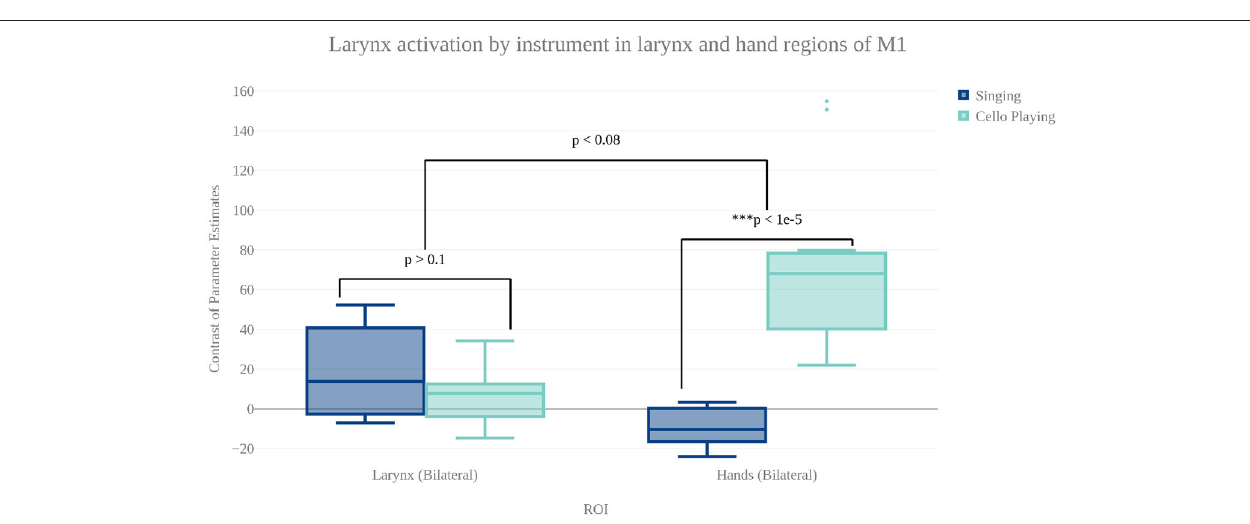
FIGURE 8 | Contrast of parameter estimates (units arbitrary) in larynx and hand area of motor cortex for singing (blue) and cello playing (turquoise). The anova showed no significant effect of instrument or brain area, but did show a significant instrument by region interaction.